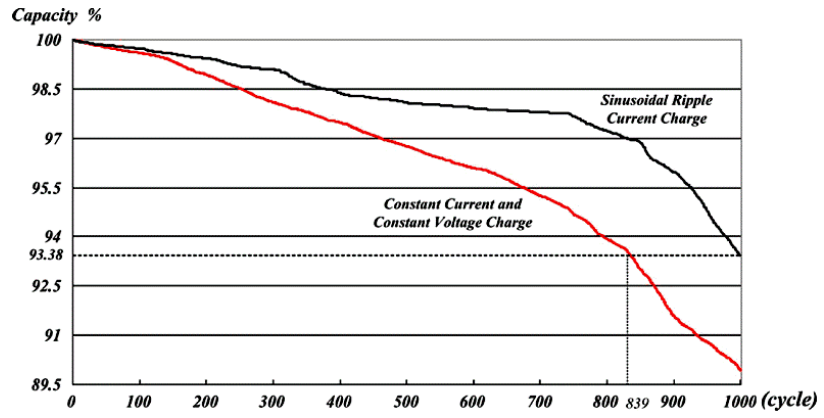
Figure 18. Deterioration curves charged by sinusoidal-ripple-current charge (SRC) and CC-CV.